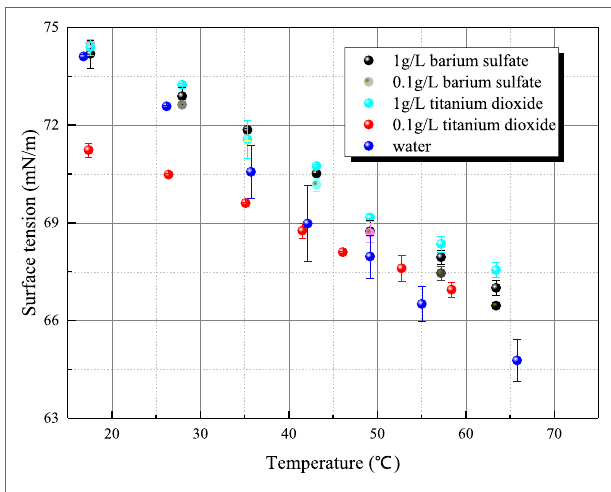
FigUre 11 | The relationship of the surface tension of solid aerosol suspension liquid and